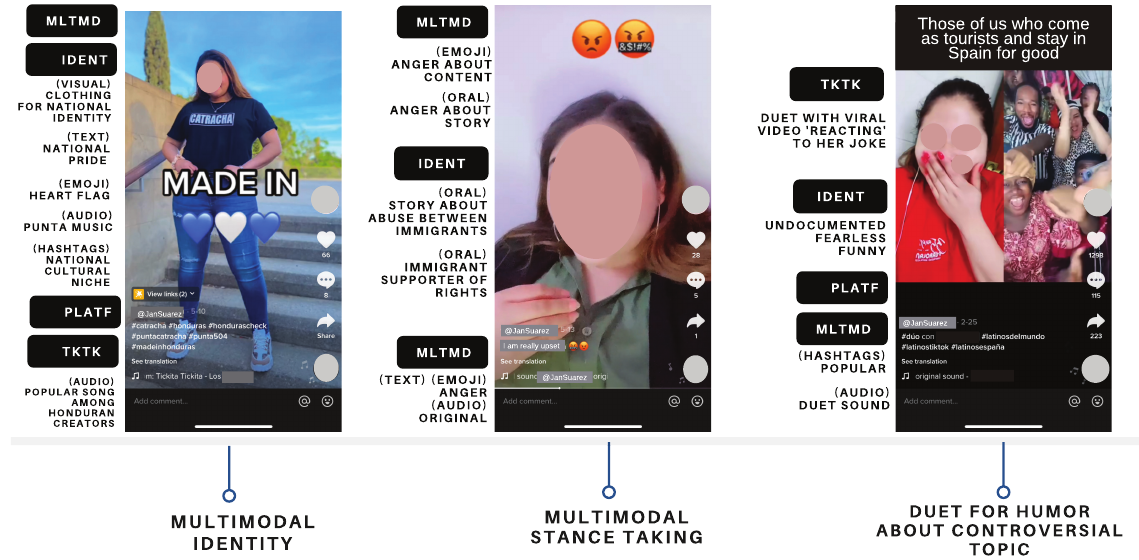
Figure 6. JanSuarez’s multimodal identity and persona‐related practices.